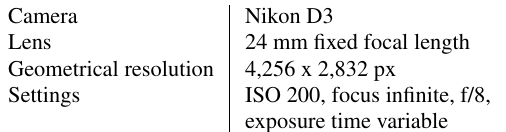
Table 1: Technical specifications and image acquisition parame- ters of the external DSLR camera used for the environment im- ages (Nikon, 2007).